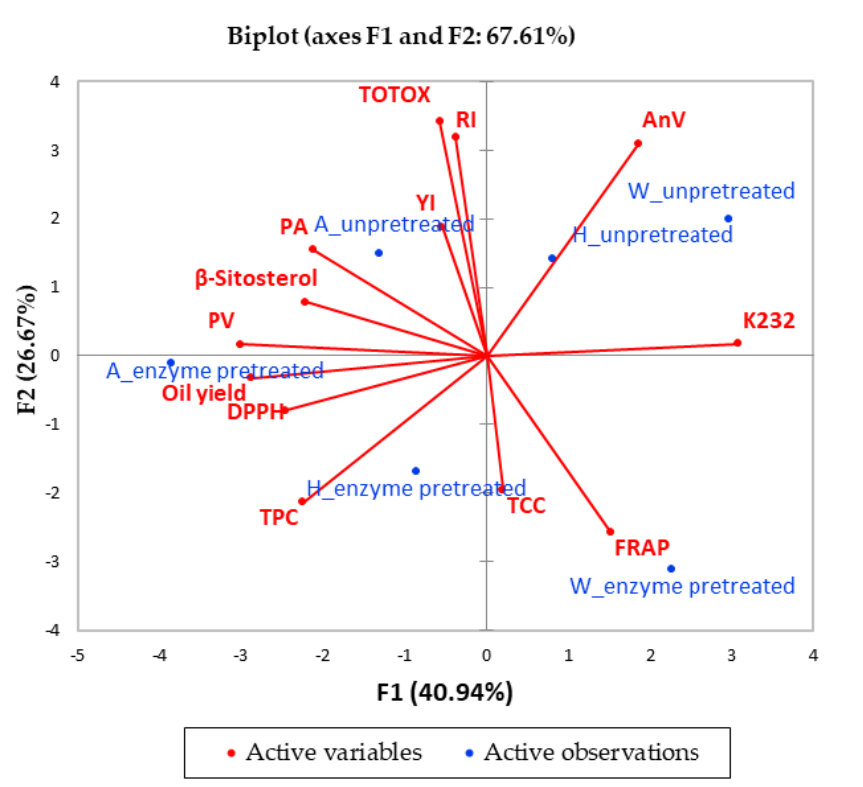
Figure 7. Principal component analysis data of pomegranate seed oil (PSO) quality attributes from un- pretreated and enzyme pretreated (1.7%, 40 ◦ C, pH = 4.5 and 5 h) seeds of the studied pomegranate cultivars, YI = yellowness index, RI = refractive index, PV = peroxide value, AV = ρ -anisidine value, TOTOX = total oxidation value, K232 = conjugated dienes, TCC = total carotenoid content, TPC = total phenolic content, PA = punicic acid, DPPH = 2.2 = diphenyl = 1 = picrylhydra- zyl, FRAP = ferric reducing antioxidant power, H = ‘Herskawitz’, W = ‘Wonderful’, A = ‘Acco’ .